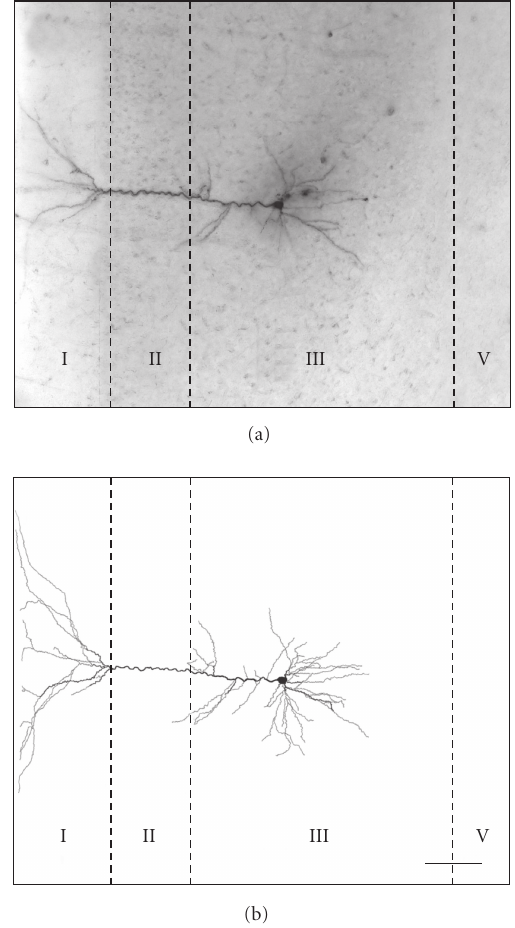
Figure 2: Example of an intracellularly labeled and reconstructed pyramidal neuron in the PFC of a control rat. (a) Photomicrograph of an intracellularly labeled pyramidal neuron in layer III of the pre- limbic subarea (left hemisphere). (b) Line drawing of the neuron shown in (a) (reconstruction with NeuroLucida). The relative po- sition of the pyramidal cell is shown by lines indicating the cortical layers (I–V). Scale bar: 100 µ